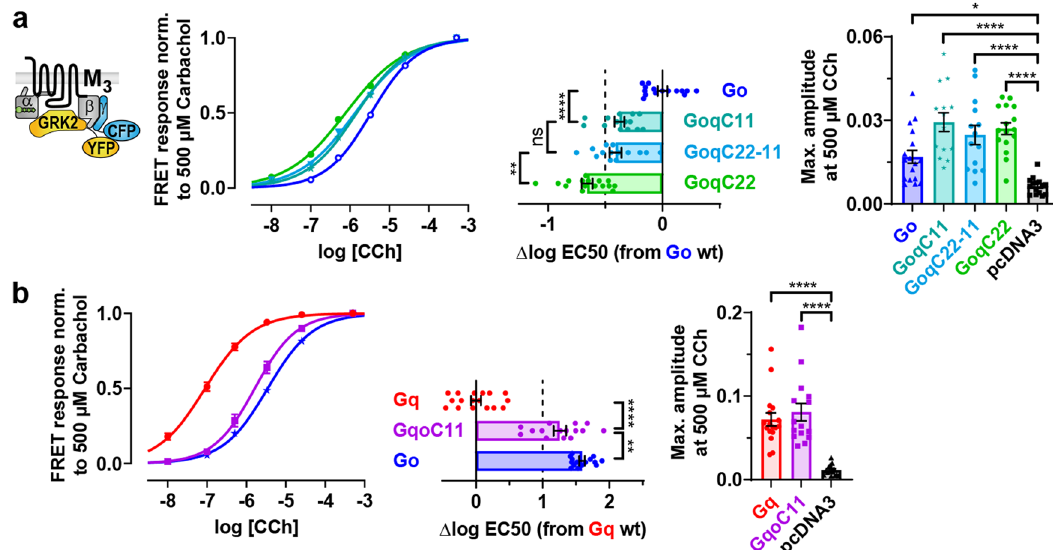
Fig. 2 Activation of C-terminally modi fi ed G proteins by M3 receptors. a – b G protein activation measurements were performed in intact HEK293T cells illuminated at 420 – 450 nm to excite the CFP-variant while simultaneously recording the YFP/CFP emission ratio. Cells were continuously superfused with buffer or buffer containing carbachol (CCh) with increasing concentrations up to a maximum of 500 µ M. Concentration-response curves were fi tted by a variable slope, the bottom fi xed to 0 and the top to 1. Individually calculated EC50 values were plotted in horizontal bars as relative changes from the averaged EC50 values of the native G proteins. All data points are represented as means ± SEM (error bars in the concentration-response curves are not visible if they were smaller than the size of the symbol) and colored as indicated in the corresponding bar graphs (Go = blue, GoqC11 = turquoise, GoqC22- 11 = light blue, GoqC22 = green, pcDNA3 = black, Gq = red, GqoC11 = purple). G protein activation was measured indirectly recruiting GRK2 by βγ - subunits with cells transfected with M 3 receptors, various G α subunits, G β 1 , N-terminally mTurquoise2-labeled G γ 2 subunits and a C-terminally mCitrine- labeled GRK2. Vertical bar graphs depict the maximum amplitudes compared to an empty vector (pcDNA3) instead of a transfected G α subunit. ( a Go; n = 15, GoqC11; n = 14, GoqC22-11; n = 14, GoqC22; n = 16 and pcDNA3; n = 15. b Gq; n = 17, GqoC11; n = 15, pcDNA3; n = 16 and Go; n = 15 duplicated from a ). Statistical analyses were performed using one-way ANOVAs followed by Tukey ’ s posttests for the EC50 values or Dunnett ’ s posttests to compare against pcDNA3 for the maximum amplitudes ( a – b , * P < 0.05, **P < 0.01, **** P < 0.0001, ns if P ≥